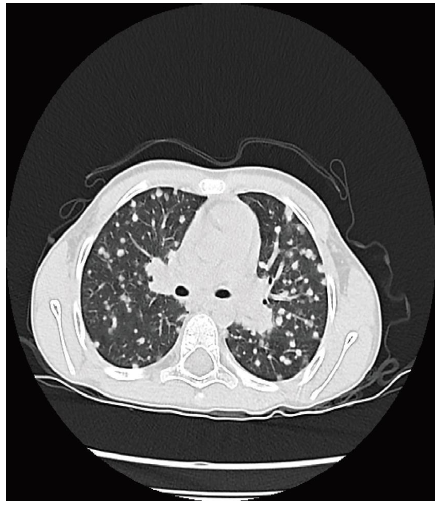
Figure 3: Multiple pulmonary nodules in both lungs on